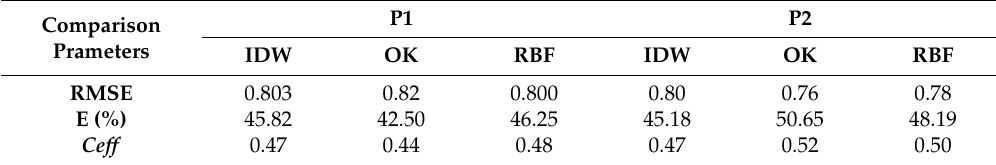
Table 4. Accuracy of interpolation methods IDW, OK, and RBF.